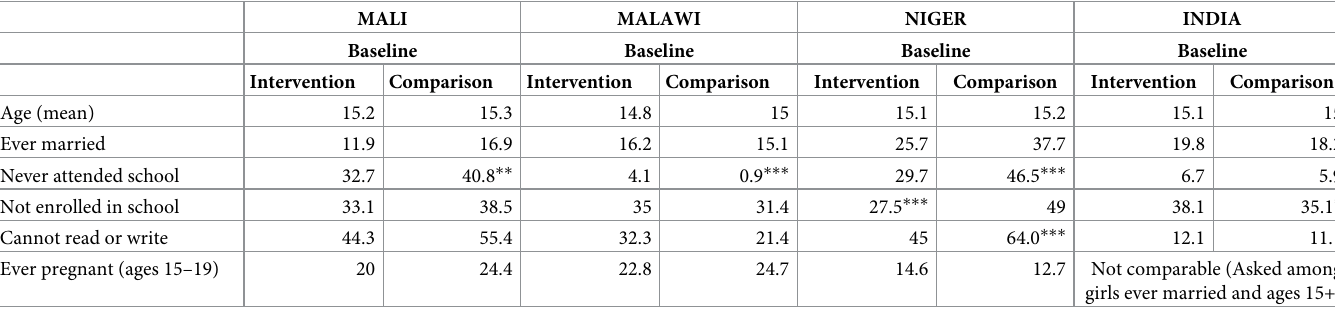
Table 1. Baseline demographics across samples, by